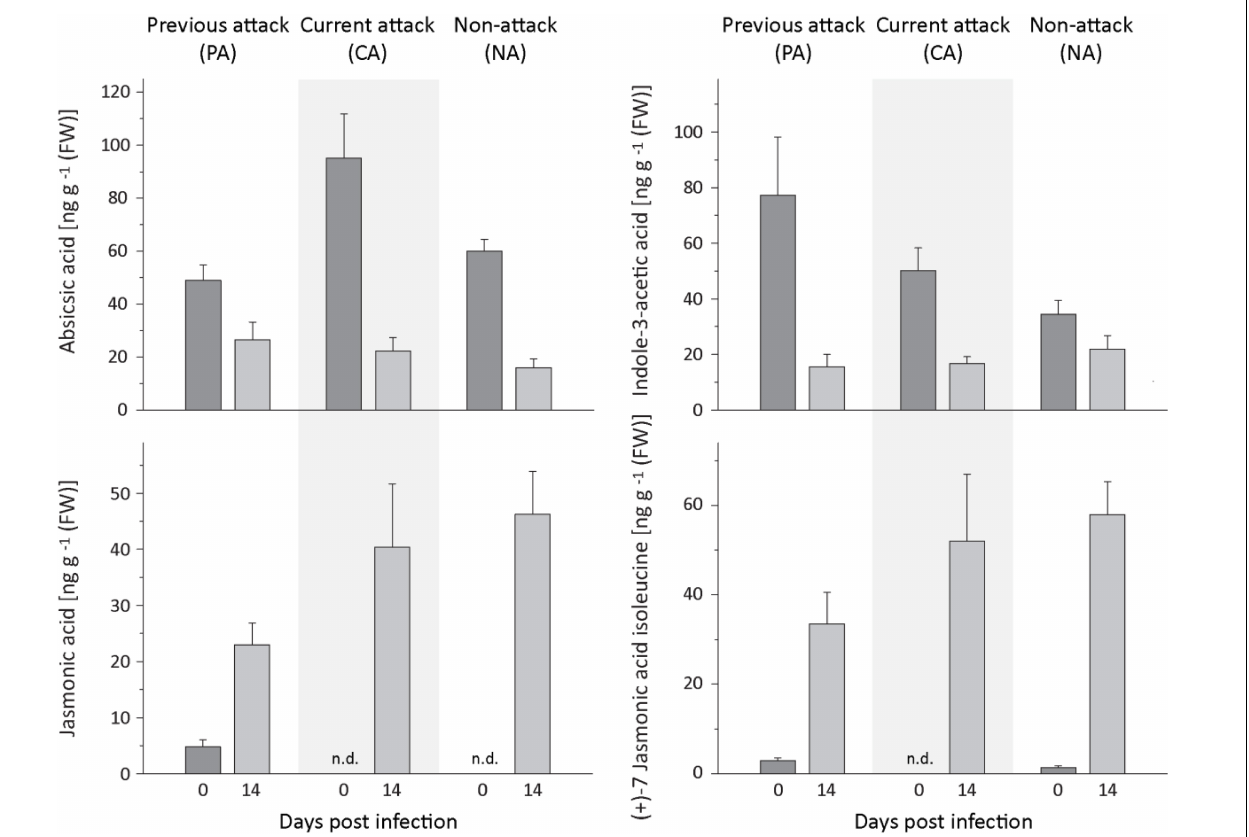
FIGURE 8 | Quantification of phytohormones in spruce bark before and after Endoconidiophora polonica infection. The concentration of abscisic acid (upper left panel) , indole-3-acetic acid (upper right panel) , jasmonic acid (lower left panel) , and the ( + )-7 jasmonic acid-isoleucine conjugate (lower right panel) were quantified by LC-MS/MS analysis from bark tissue harvested before and 14 days after infection with E. polonica . Trees investigated: (1) were from a stand with a history of previous bark beetle attack, but no current attack (PA), (2) were under current attack, but had no previous history of attack (CA), or (3) had no previous nor current attack (NA). Data are means ± SD of measurements from 6 to 12 biological replicates; exact numbers are given in the Section “Materials and Methods.” Statistical values for individual compounds are given in Supplementary Table 9